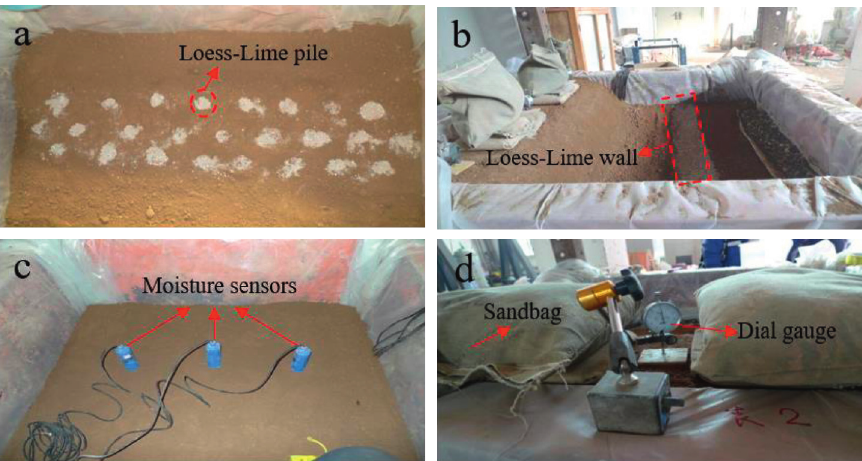
Figure 4: Filling diagram of the model box. (a) Loess-lime compaction pile. (b) Diaphragm wall. (c) Moisture sensor. (d) Subgrade loading and dial indicator.